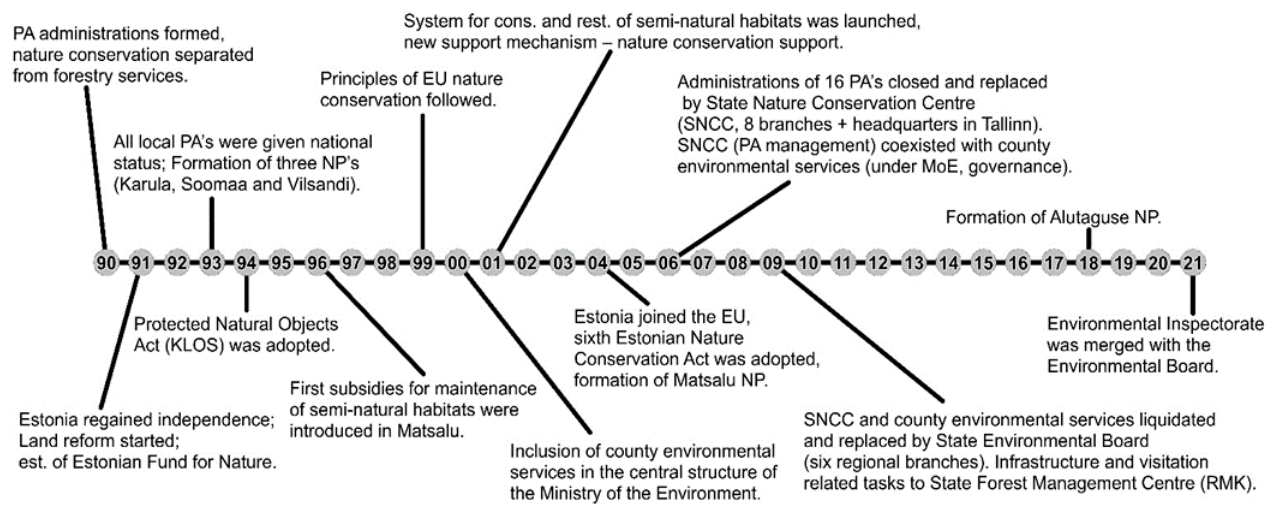
Figure 1. Timeline of important events affecting nature conservation in Estonia.